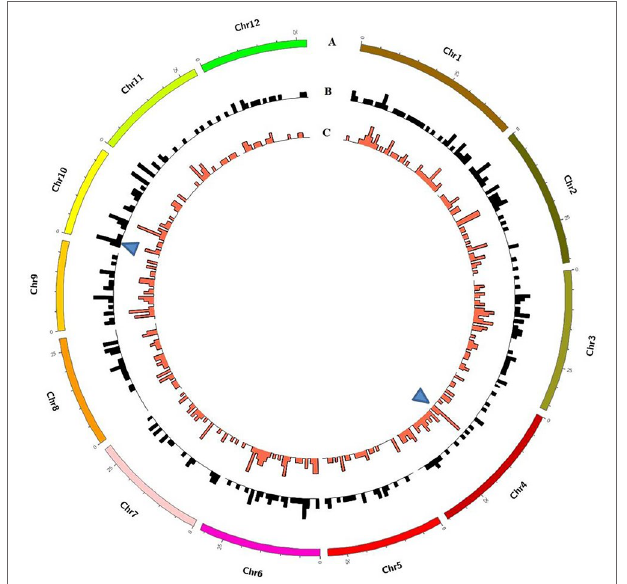
FIGURe 5 | Genome-wide Characterization of Mutations in rice induced by and CIBs and GRs. (a) Representation of the 12 rice chromosomes on an Mb scale. (B) CIB-induced mutations in non-overlapping 100-kb windows.